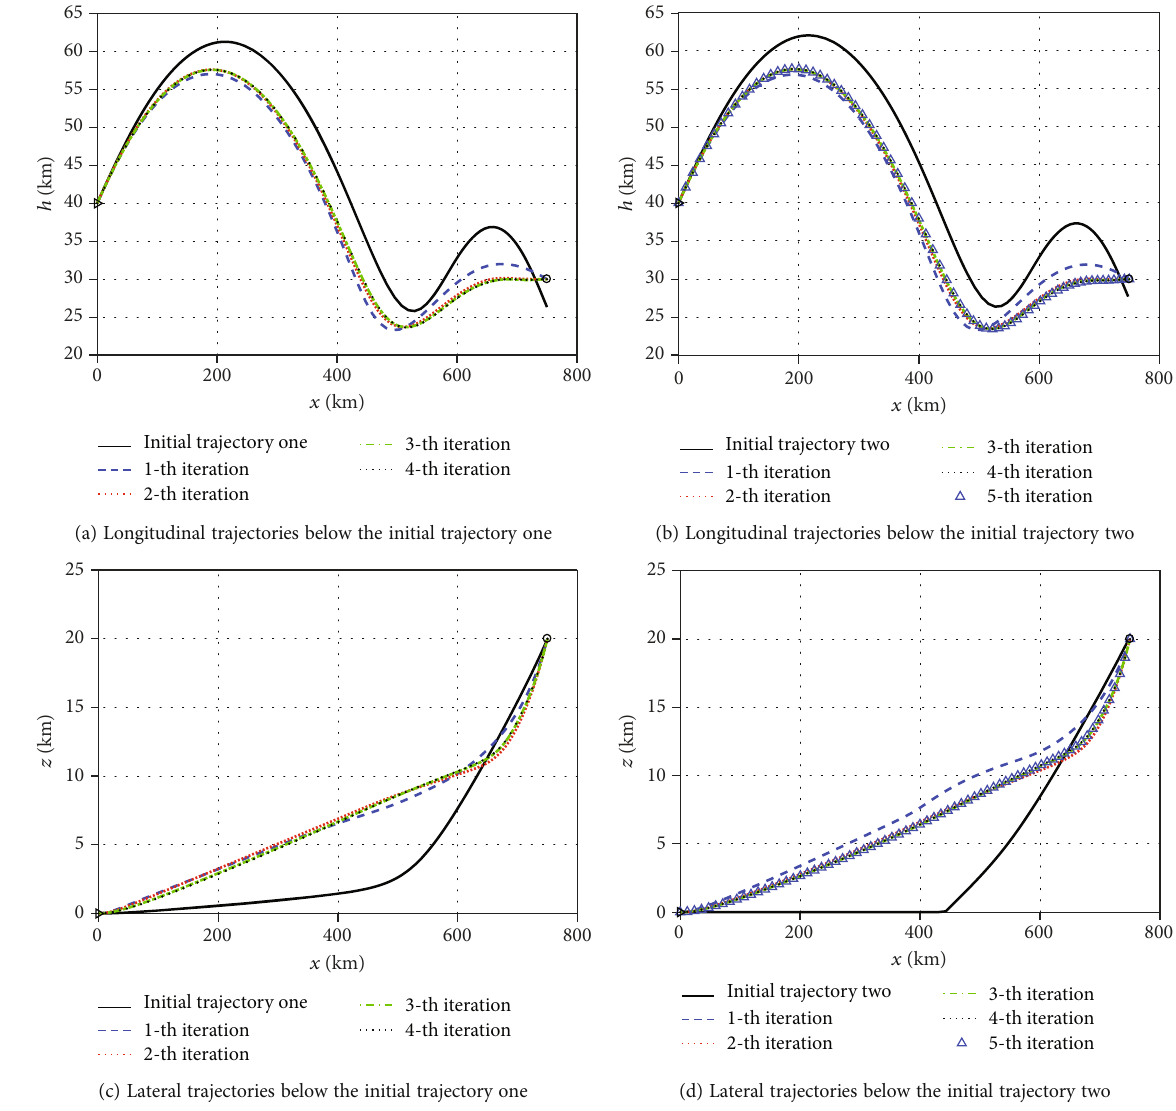
Figure 13: Iterative trajectories of di ff erent initial reference trajectories. Initial trajectory one is generated by the fast trajectory generation method in this paper, and initial trajectory two is generated by the method in reference